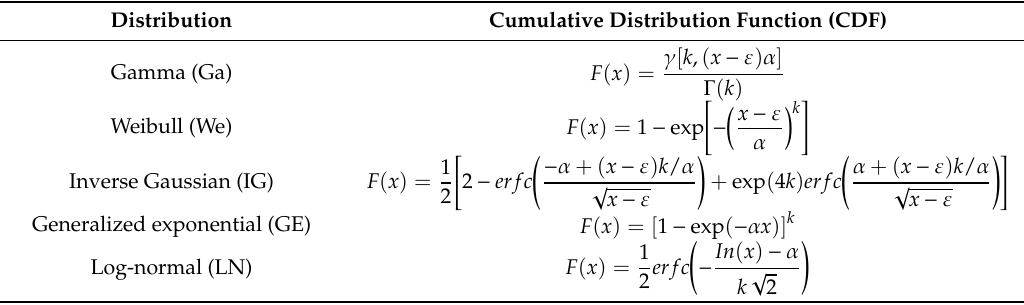
Table 1. Cumulative distribution functions used in the paper.